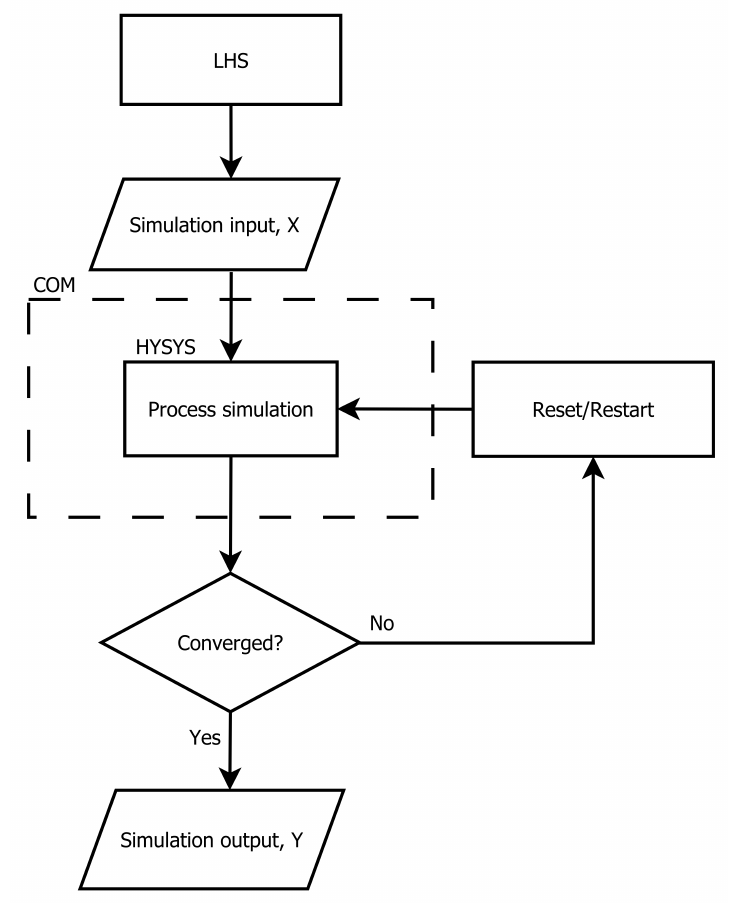
Figure 3. Calculationflow for Latin-Hypercube sampling using the process